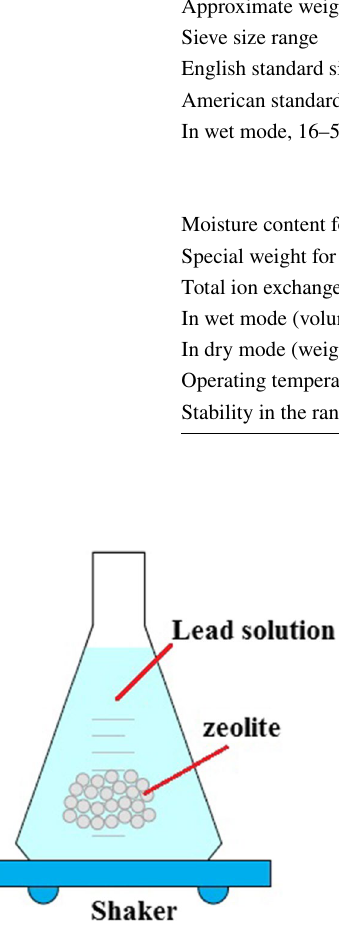
Fig. 2 Scheme of experimental procedure for adsorption